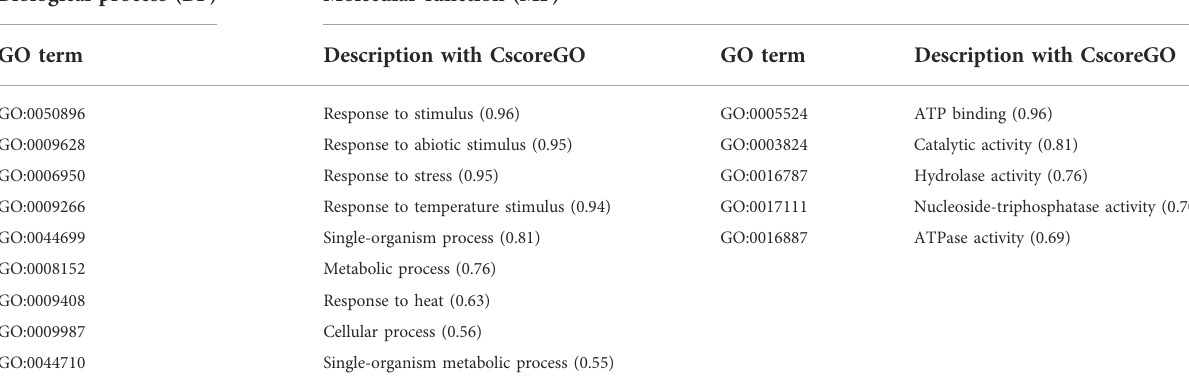
TABLE 2 In silico functional annotation of Ds-DbRCaG-01-Rga1 predicted through COFACTOR and COACH web-based